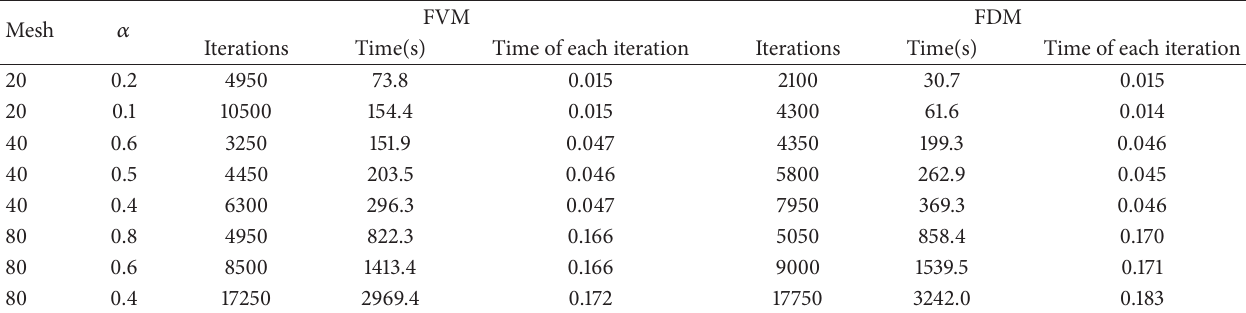
Table 5: Computation iterations and time of FVM and FDM in second-order central difference scheme for vorticity-stream function algorithm of lid driven